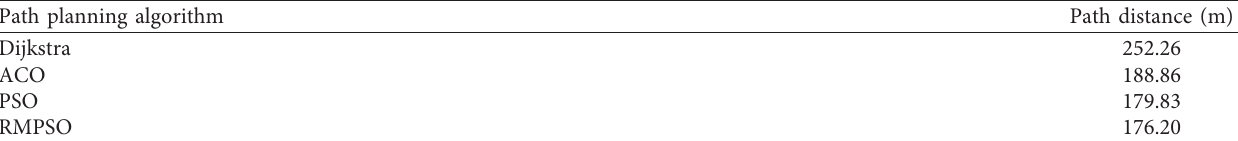
Table 2: Comparison of path